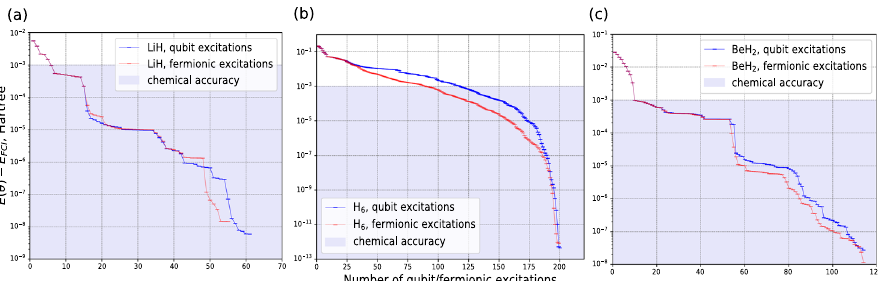
Fig. 3 Comparison of the qubit and fermionic-excitation evolutions at equilibrium bond distances. The three sub fi gures present energy-convergence plots for the ground states of: a LiH, b H 6 , and c BeH 2 , in the STO-3G orbital basis set, at bond distances of r Li − H = 1.546 Å , r H − H = 1.5 Å , and r Be − H = 1.316 Å , respectively. The blue plots are obtained with the QEB-ADAPT-VQE for n = 1 and step 5 not implemented. The red plots are obtained with the fermionic-ADAPT-VQE using an ansatz-element pool of non-spin-complement fermionic-excitation evolutions. The plots are terminated at ϵ = 10 − 12